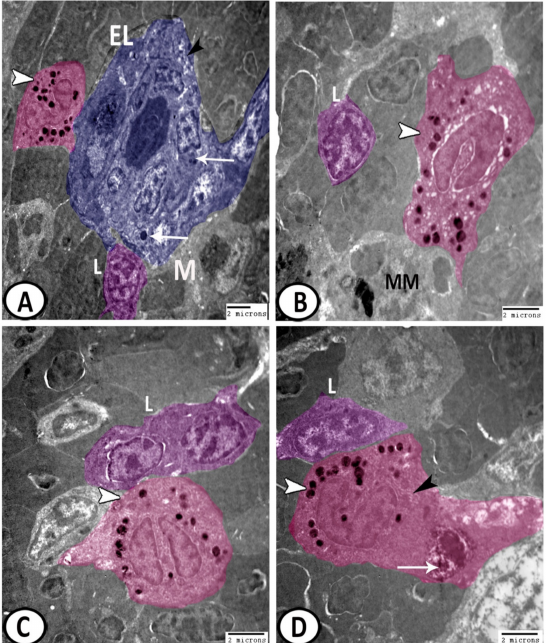
Figure 10. Digital colored TEM of the leukocytes in the spleen. ( A ) The ellipsoids (blue, E) were lined with a simple cuboidal epithelium and contained lysosomes (arrows), and vacuoles (black arrowhead). Note the surrounding macrophage (M), lymphocytes (L, violet), and eosinophils (pink, white arrow- head). ( B ) Eosinophils (pink, arrowhead) displayed horseshoe-shaped nuclei and rounded electron- dense granules and vesicles. Note the presence of lymphocytes (L, violet) and melanomacrophages (MM). ( C ) The cytoplasm of basophil (pink, arrowhead) was packed with electron-dense granules. Note the associated lymphocytes (L, violet). ( D ) Neutrophils (pink) with a segmented nucleus, and many electron-dense granules (white arrowhead), rER (black arrowhead), and phagocytosed materials (arrow). Note the presence of lymphocytes (L,